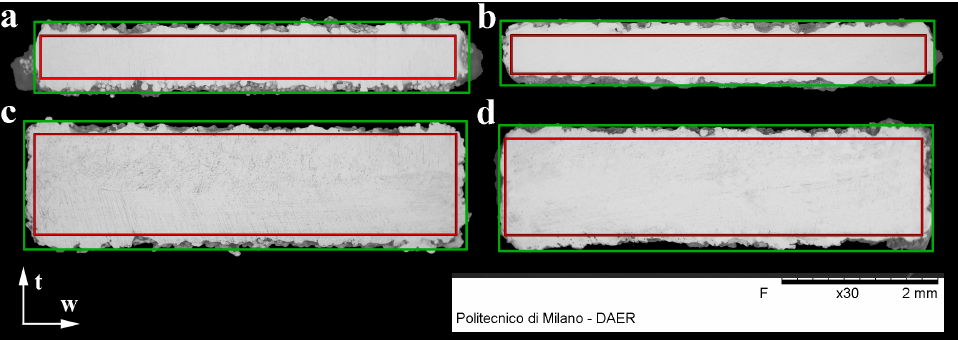
Figure 8. Cross-sections for ( a ) 90 ◦ , 0.8 mm thickness; ( b ) 0 ◦ , 0.8 mm thickness; ( c ) 90 ◦ , 1.6 mm thickness; and ( d ) 0 ◦ , 1.6 mm thickness